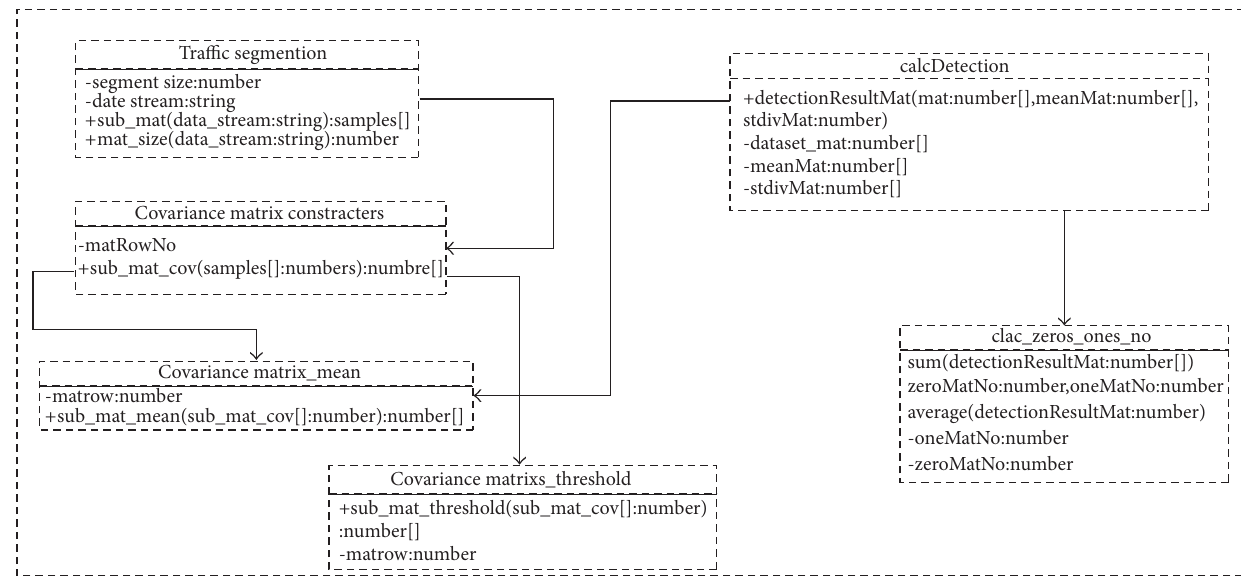
Figure 1: MADM class